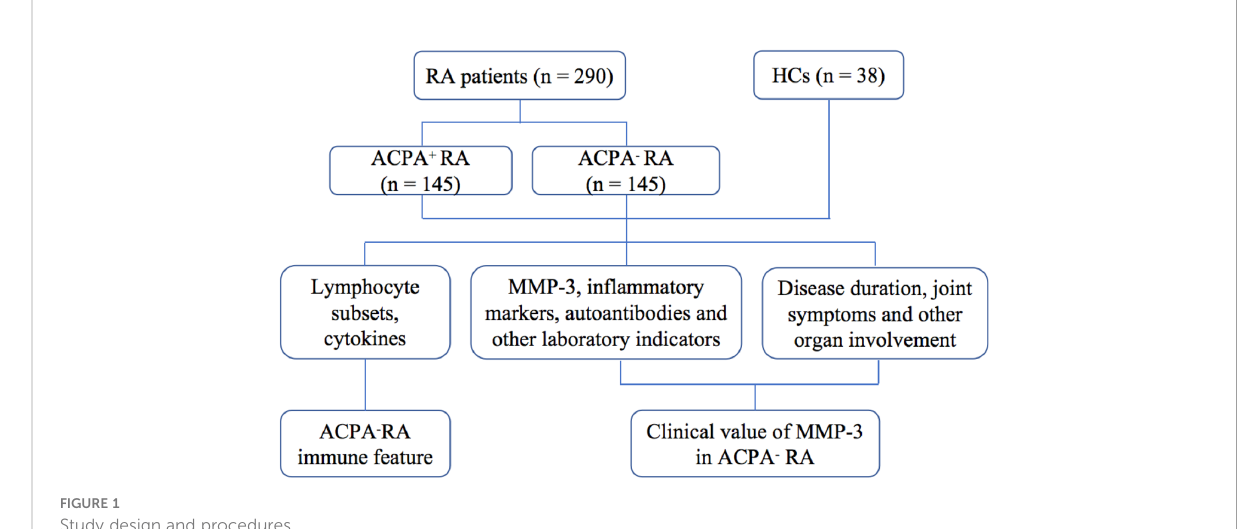
FIGURE 1 Study design and